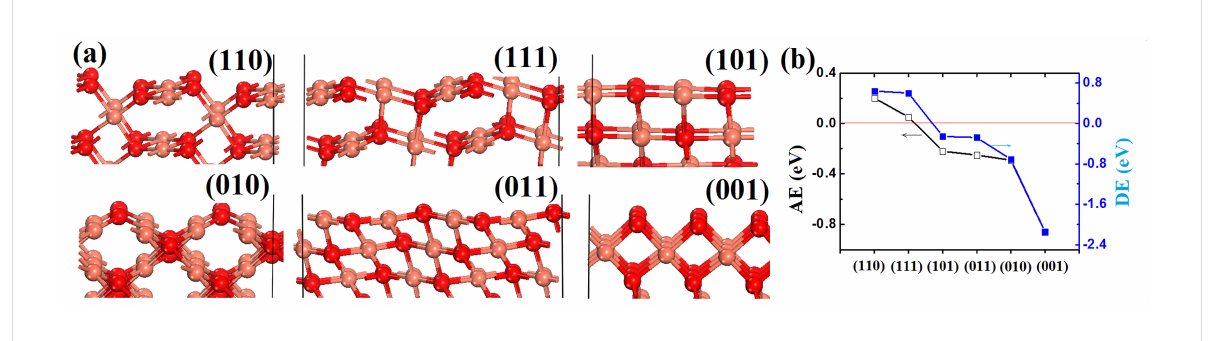
Figure 1: Computational screening. (a) Models for six low-index surfaces (unrelaxed); (b) Calculated values of AE and DE. Cu and O are shown as rose-carmine and red,